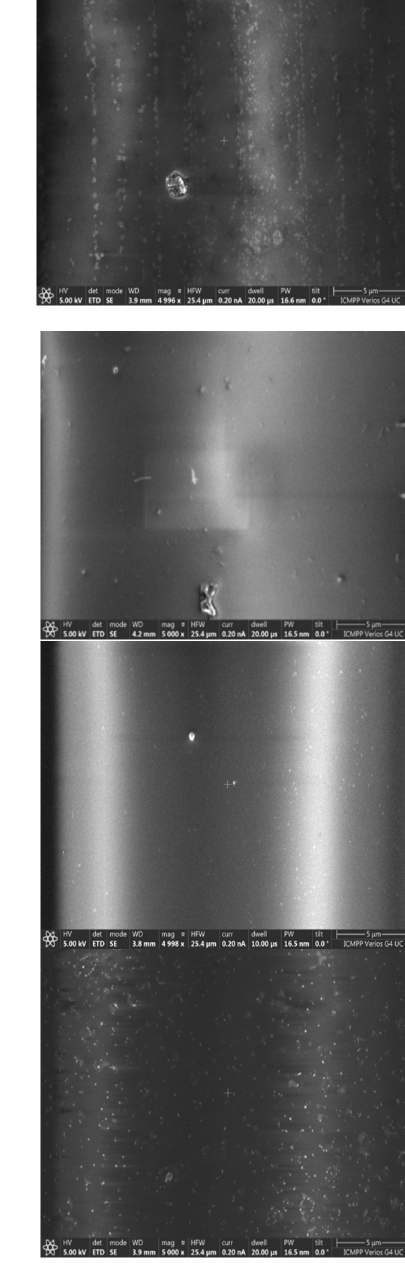
Figure 2. SEM images of P1 – P4 films deposited from chloroform solution by drop-casting (DC) and spin-coating (SC) techniques (scale 5 µm).